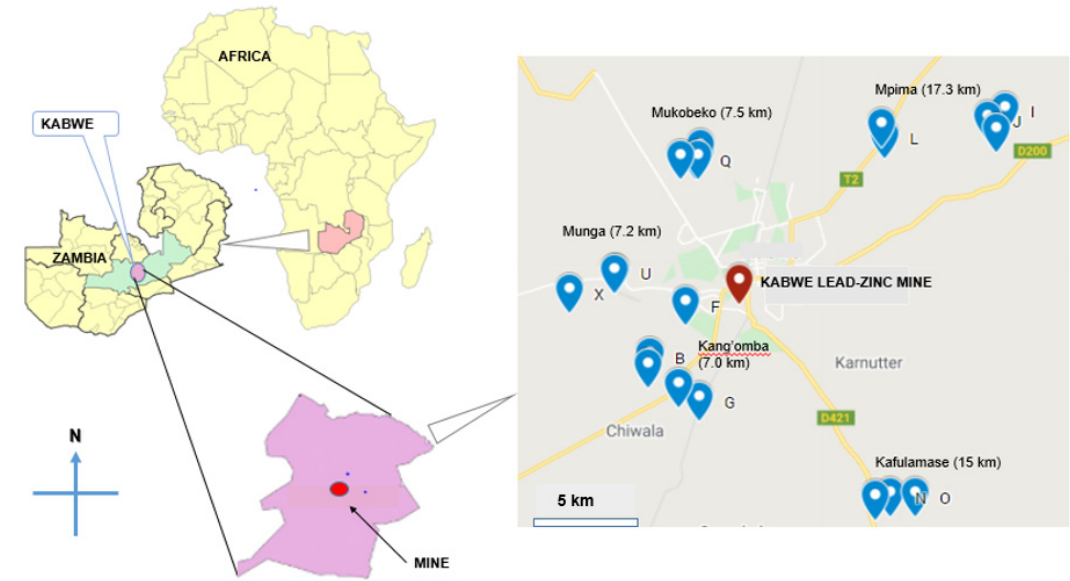
Figure 1. GPS map (modified from Google My Maps) showing sampling locations around the Pb–Zn mine in five regions of Kabwe (Kang’omba n = 56; Mpima, n = 54; Kafulamase, n = 35; Mukobeko, n = 59; Munga, n = 10).